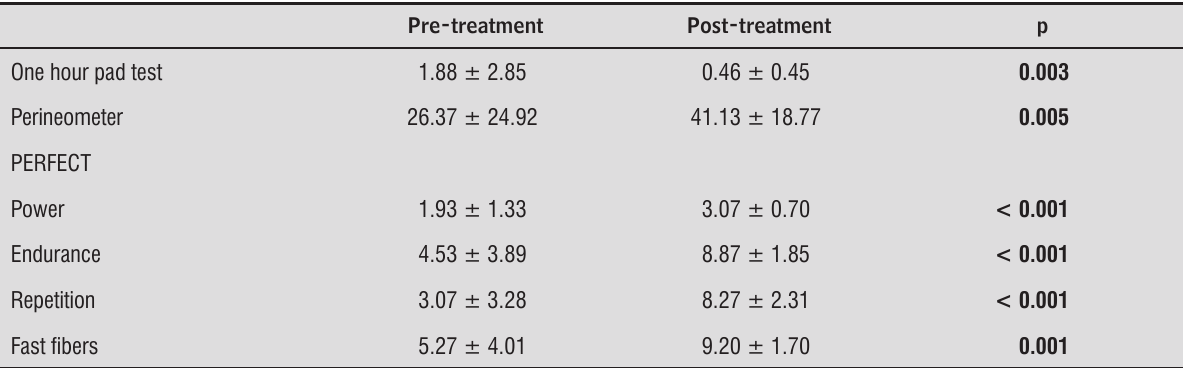
Table 1 - Outcomes of one-hour pad test, pelvic floor muscle function digital (PERFECT) and perioneometer